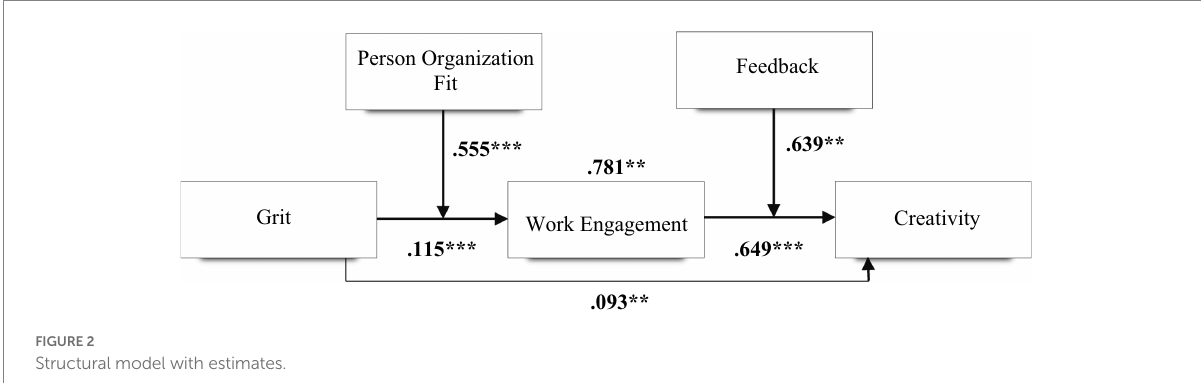
FIGURE 2 Structural model with